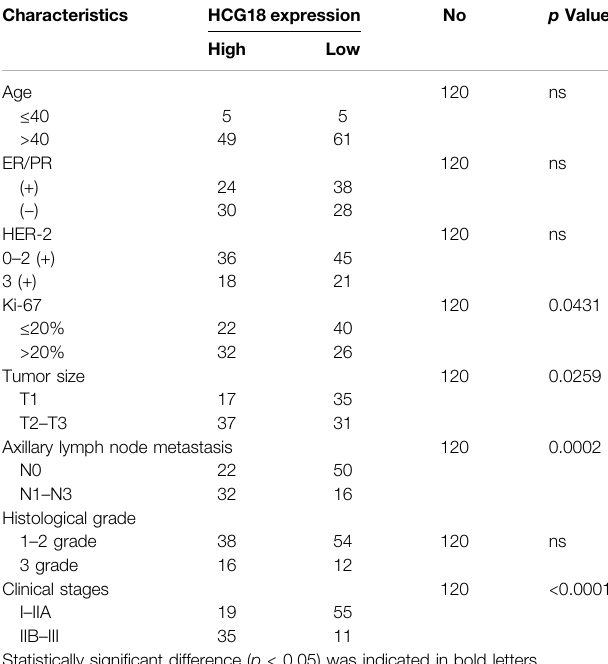
TABLE 1 | Association HCG18 expression and patients ’ clinicopathological characteristics in invasive ductal carcinoma tissues.